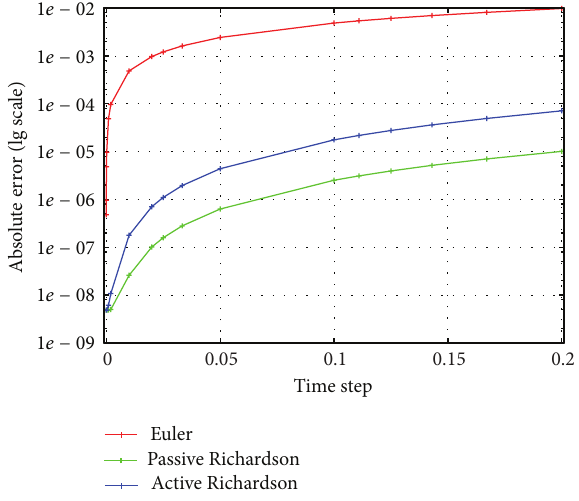
Figure 7: Absolute error as a function of time step in case of the advection problem for the Euler method without and with passive and active Richardson extrapolation. In the simulation the grid step was Δ𝑥 = 1 and advection velocity 𝑢 = 0.1 . The reference solution was calculated using Δ𝑡 = 10 −7